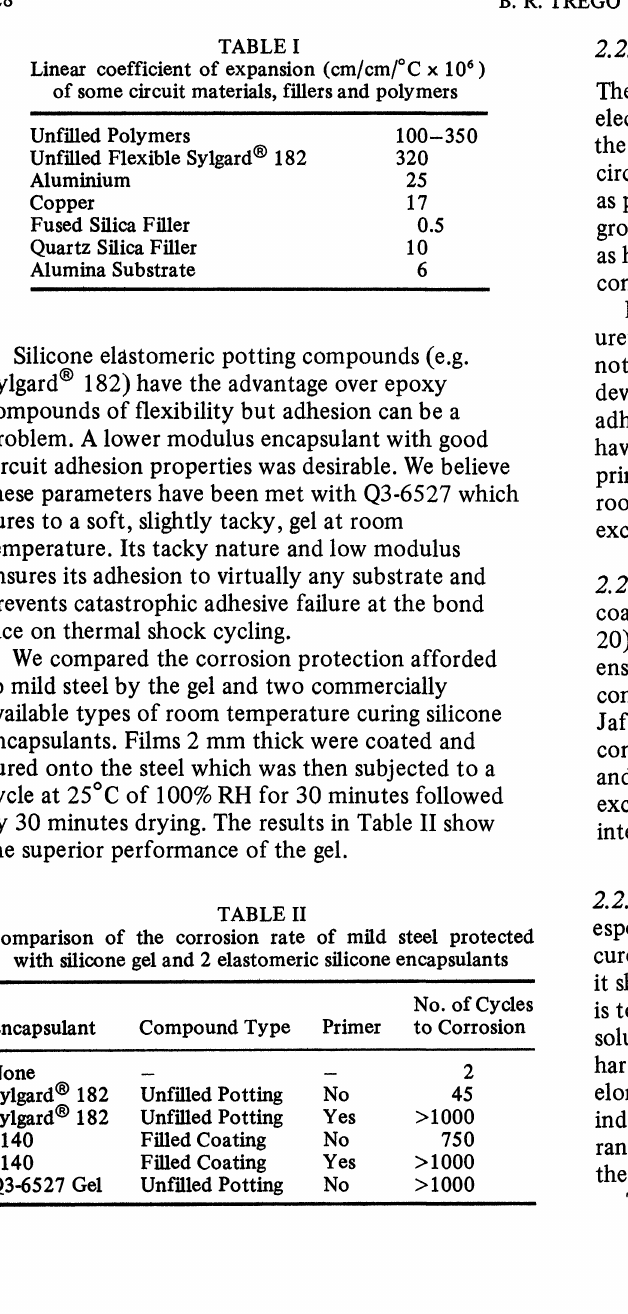
TABLE Linear coefficient of expansion (cm/cm/ C x 10 of some circuit materials, fillers and polymers Unfilled Polymers